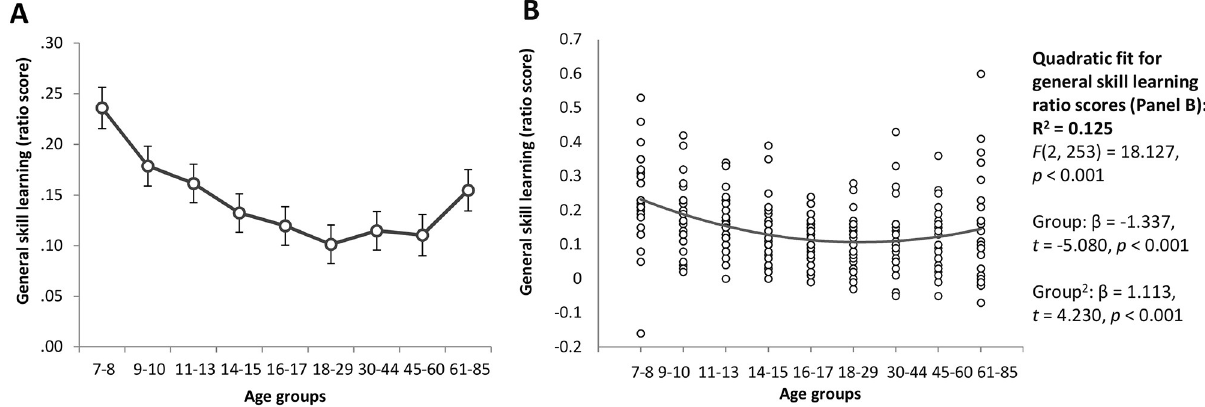
Fig 2. General skill learning ratio scores across the lifespan. The ratio scores for group averages (A) and individual data (B) are presented. The ratio score can be interpreted as a percentage change in performance (e.g., the 7-8-old age group exhibited an approximately 23% speed-up from Epoch 1 to Epoch 4 relative to their average speed during task). Error bars indicate standard error of mean (SEM).